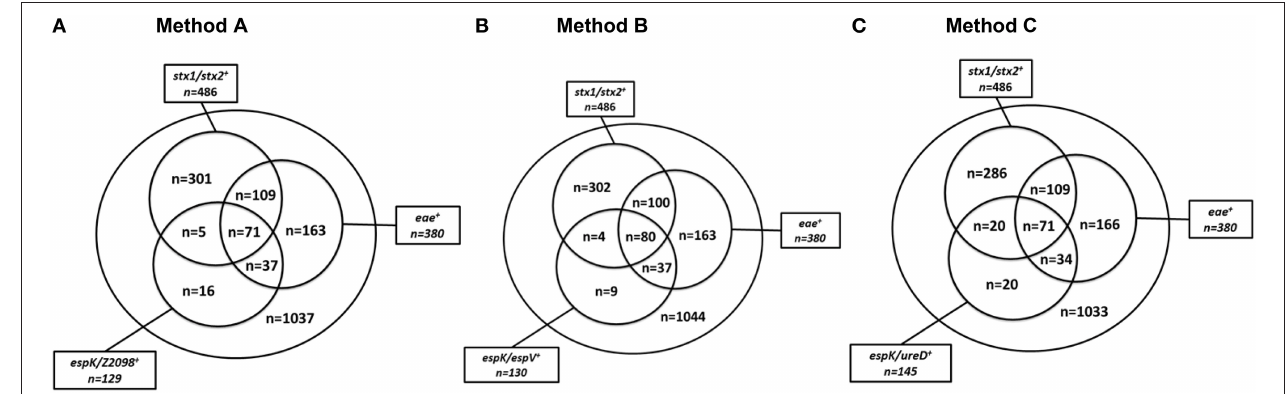
FIGURE 1 | Distribution of the genetic markers stx , eae , espK , espV , and Z2098 among 1739 beef samples. (A) ( stx1 / stx2 , eae, and espK / Z2098 ) is Method A, (B) ( stx1 / stx2 , eae, and espK / espV ) is Method B, (C) ( stx1 / stx2 , eae, and espK / ureD ) is Method C. stx 1/ stx 2 + for samples giving a positive result for stx1 and/or stx2 , eae + for samples giving a positive result for eae , espK / Z2098 + for samples giving a positive result for espK and/or Z2098 , espK / espV + for samples giving a positive result for espK and/or espV , espK / ureD + for samples giving a positive result for espK and/or ureD